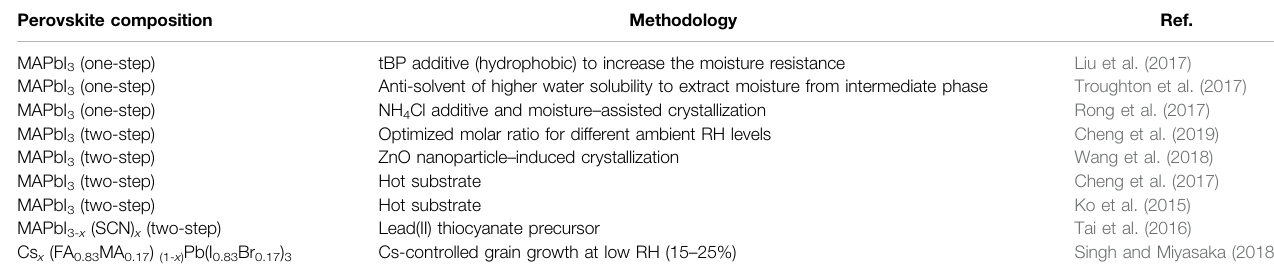
TABLE 1 | Strategies to control the nucleation and growth of perovskite fi lms fabricated in ambient conditions. Perovskite